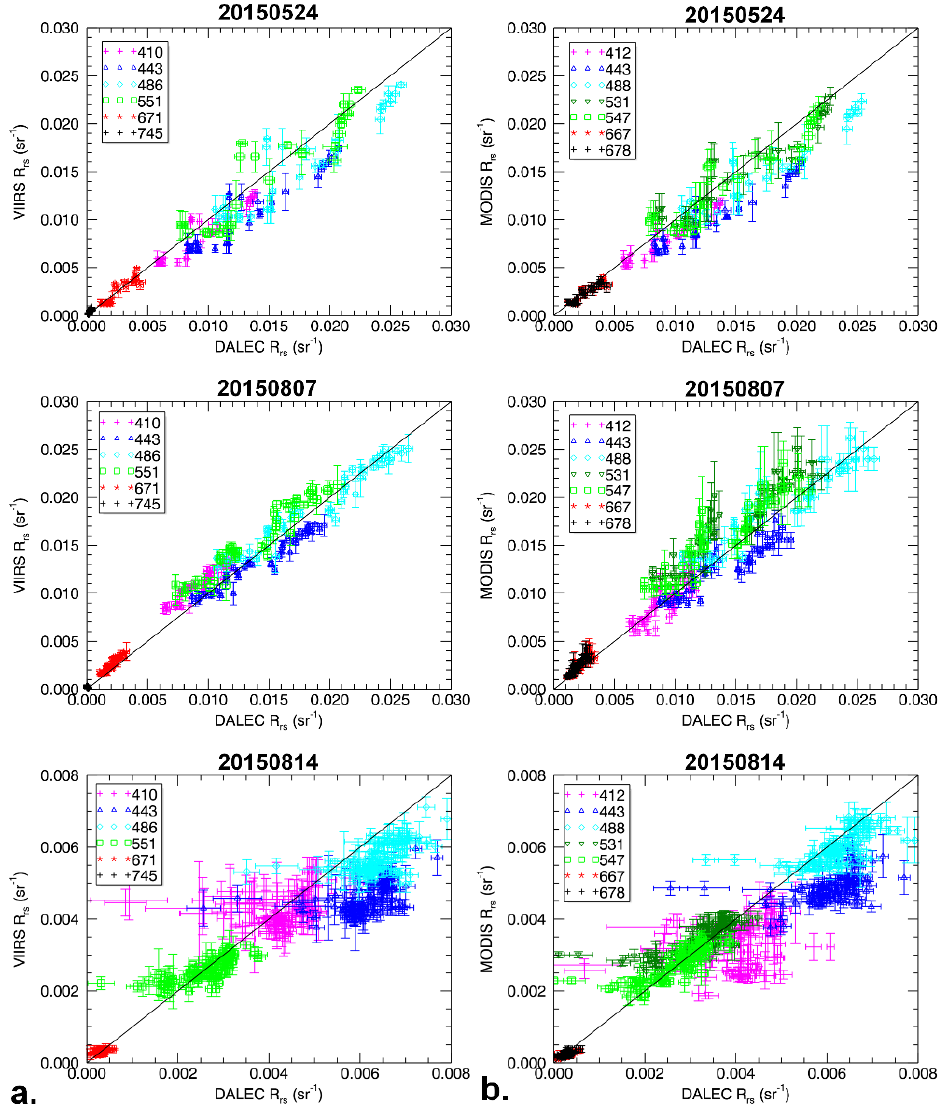
Figure 7. Spectral comparison in the Timor Sea for the dates shown and transects illustrated in Figure 2c, ( a ) VIIRS data; ( b ) MODIS data. DALEC data are aggregated to approximately 1km scale. Error bars on DALEC data represent the standard deviation over the aggregation period and error bars on satellite data indicate the standard deviation over a 3x3 neighborhood of pixels.